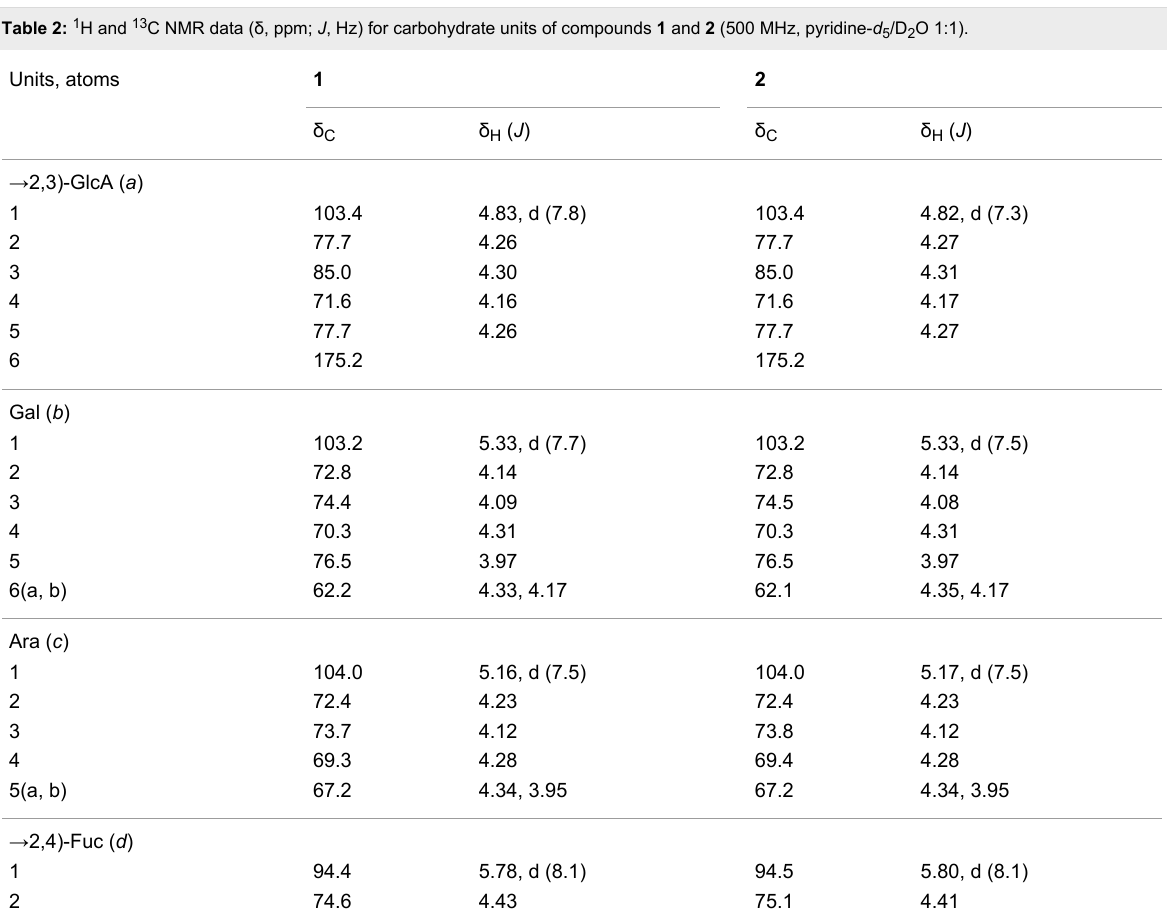
Table 2: 1 H and 13 С NMR data ( δ , ppm; J , Hz) for carbohydrate units of compounds 1 and 2 (500 MHz, pyridine- d 5 /D 2 O 1:1).